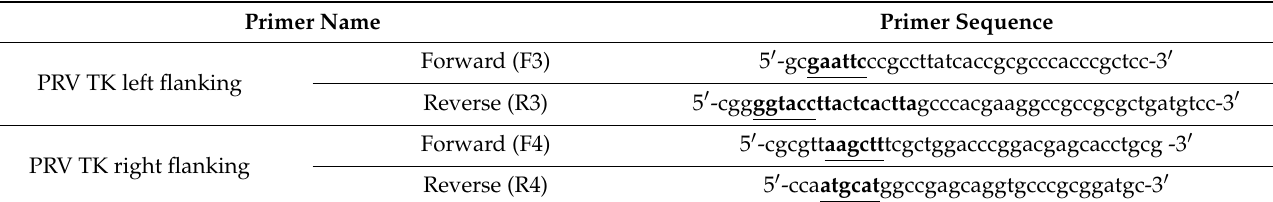
Table 1. List of primers used to construct the gE-deleted and TK-null/deleted recombinant viruses. Restriction enzyme cleavage sites are bold and underlined. Stop codons are highlighted in bold.